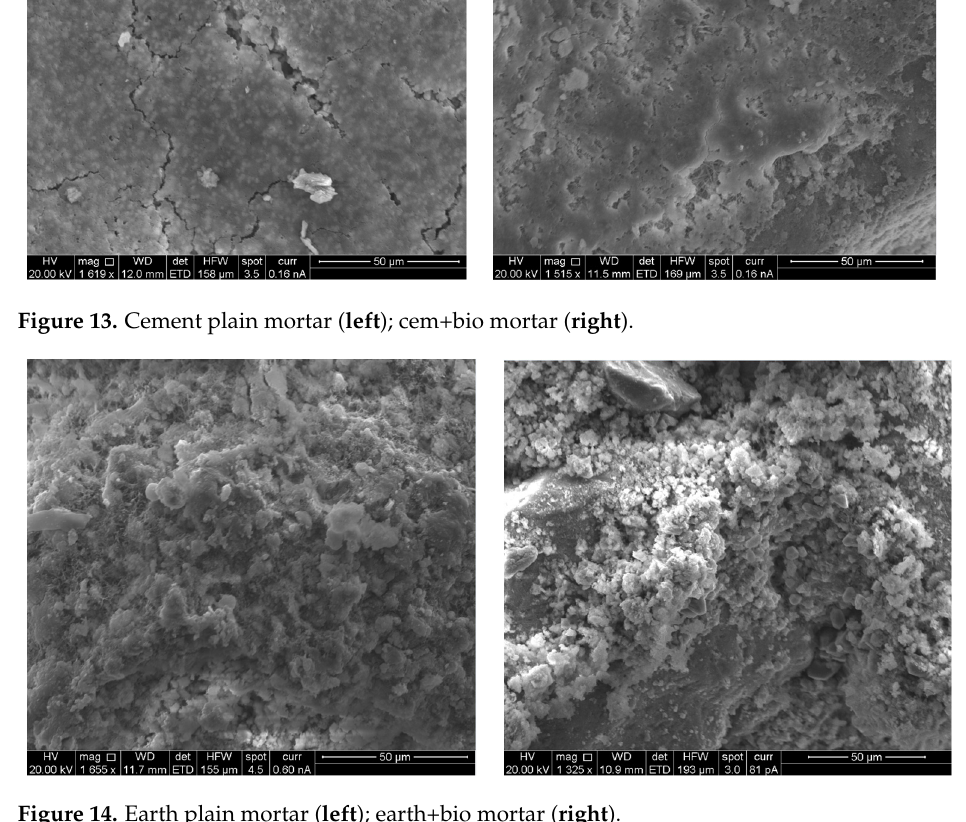
Figure 14. Earth plain mortar ( left ); earth+bio mortar ( right ).